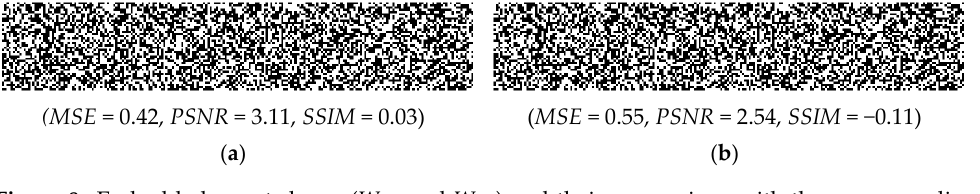
Figure 8. Embedded secret shares ( W S 1 and W S 2 ) and their comparison with the corresponding original shares ( S 1 and S 2 , illustrated in Figure 4b,c) using the MSE, PSNR and SSIM . ( a ) First embedded secret share W S 1 (MSE = 0.42, PSNR = 3.11 and SSIM = 0.03 when compared with S 1 ). ( b ) Second embedded secret share W S 2 ( MSE = 0.55, PSNR = 2.54 and SSIM = − 0.11 when compared with S 2 ).